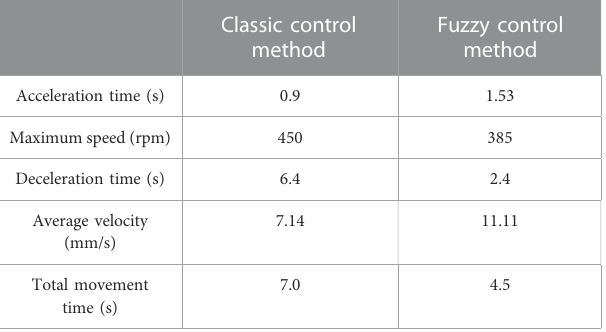
TABLE 4 Experiment comparison between classical and fuzzy